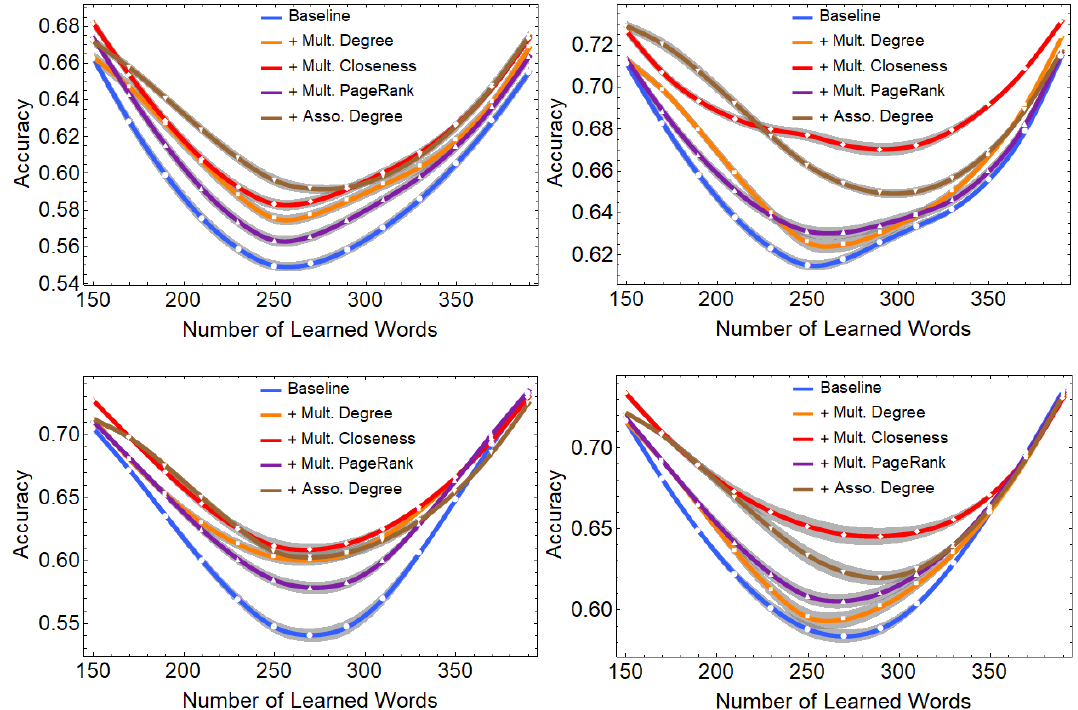
Figure 3. Accuracy for predicting early word learning with different models and different classifiers, namely naive Bayes ( top left ), logistic regression ( top right ), random forest ( bottom left ) and support vector machine ( bottom right ). The baseline model includes word frequency, length, polysemy scores and is-a-noun flags. Other models include also one of the following: multiplex degree, multiplex closeness centrality, multiplex PageRank and free association degree. Different developmental stages are considered spanning vocabulary sizes from 150 to 400 words, corresponding to months 22 and 26 of age. Error margins are reported in grey and represent standard deviations over the ensemble of partially randomised normative rankings r ∗ and cross-validation iterations (see i